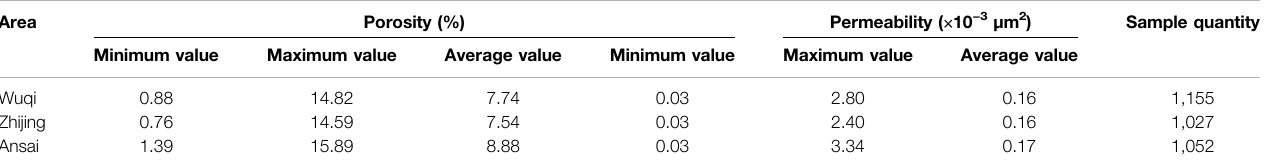
TABLE 4 | Reservoir physical property of Chang 8 in Wuqi – Zhijing – Ansai area.